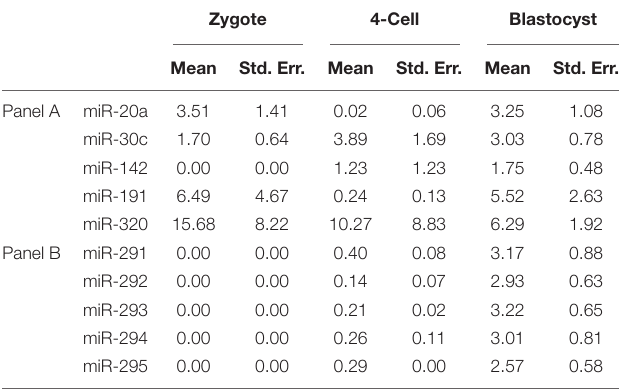
TABLE 2 | Calculated extracellular miRNA transcript microdroplet abundance expressed as a percentage of that found within the whole embryo cohort at various developmental stages.